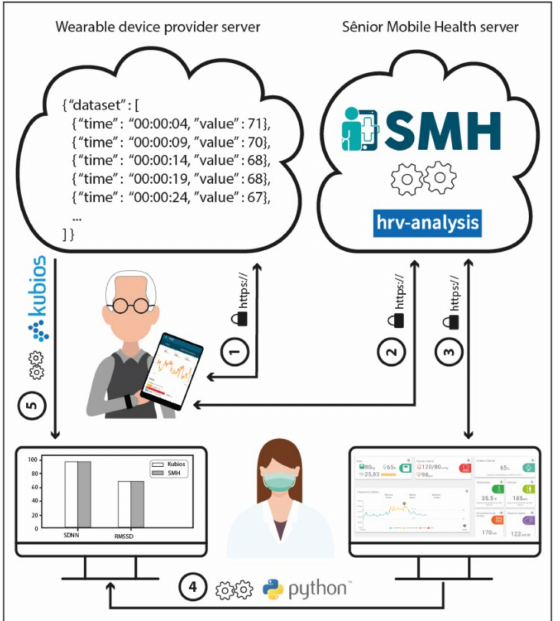
Figure 15. Information flow of the experiment to validate HRV parameters in the SMH platform.